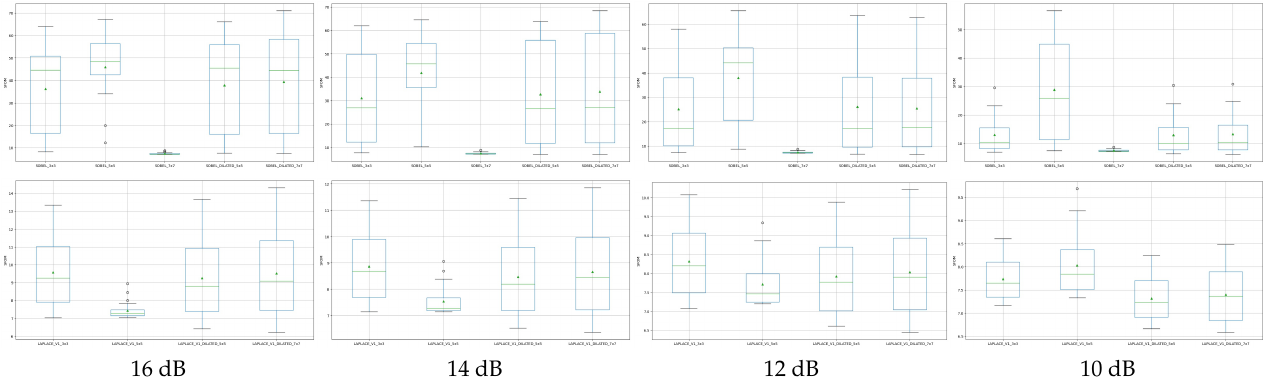
Figure 13. SFoM results for first-order-based operators on different levels of noise (PSNR) on the test image; Rows are: first-order derivative orthogonal gradient operators; Laplace edge